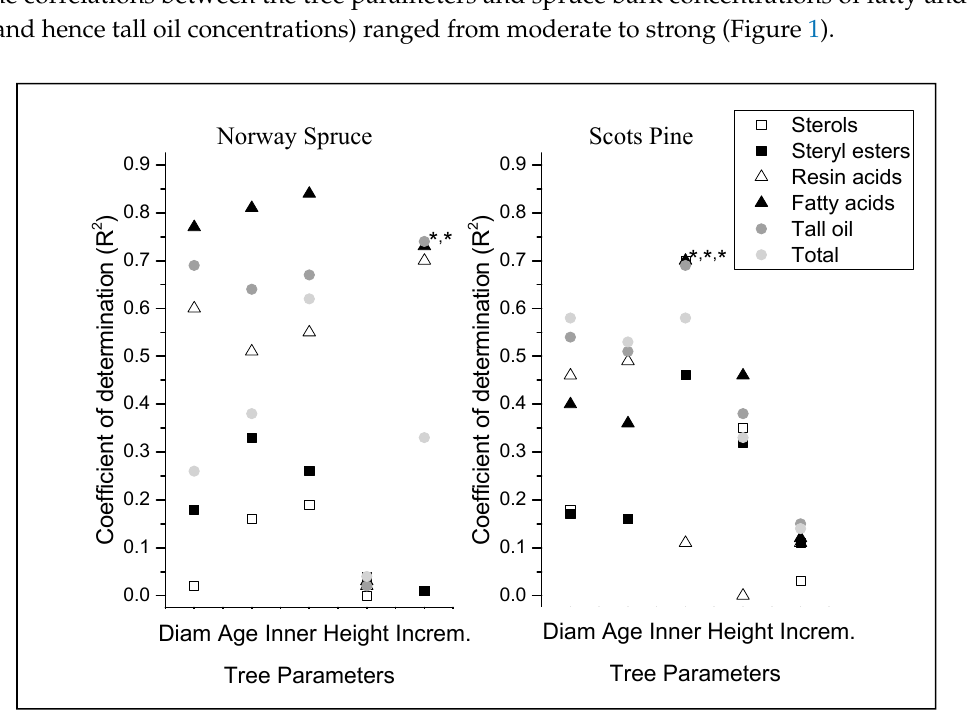
Figure 1. Coefficients of determination (indicating accuracy of predictions) from linear regression analysis based on the measured tree parameters for content of extractive compounds in Norway spruce and Scots pine bark samples. Diam, stem diameter; Age, number of annual rings; Inner, inner bark proportion; Height, sampling height in trees; and Increm., average annual ring increment in the last 10 years. * significant parameter ( p ≤